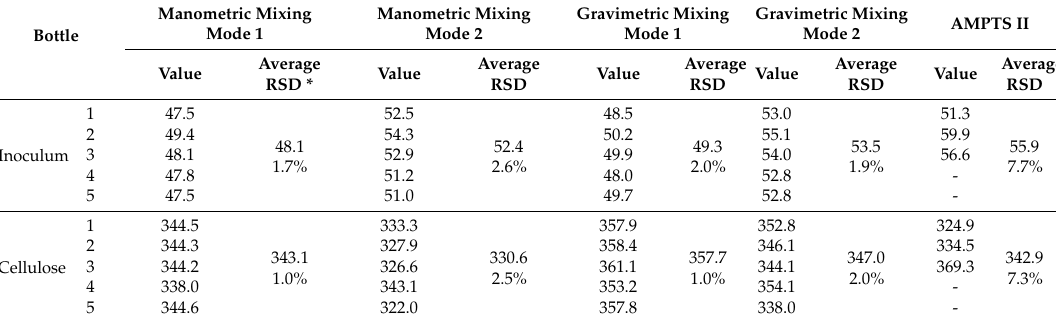
Manometric Mixing Mode 1